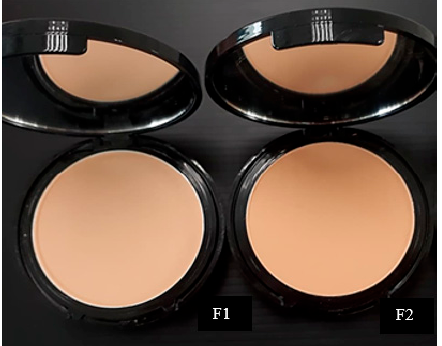
Figure 4. The appearance of the compact powders: the talcum compact powder (F1) and rice flour replaced talcum (F2).